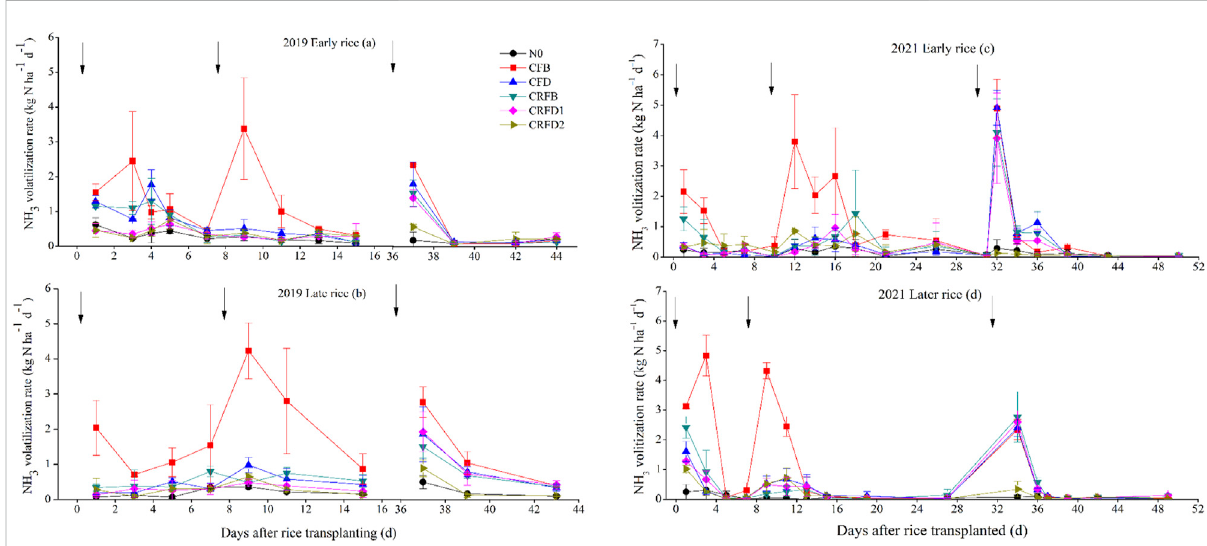
FIGURE 2 The NH 3 volatilization fl uxes for early (A,C) and late rice (B,D) under different treatments in 2019 (A,B) and 2021 (C,D) . Values are presented as the mean ± standard deviation ( n = 3). The arrow represents the timing of N fertilizer application, following basal, tillering and panicle fertilizations, respectively.N0:noNfertilizer;CFB:compoundfertilizerbroadcasting;CFD:compoundfertilizerside-deepplacement;CRFB:controlled-releaseN fertilizer broadcasting; CRFD1: controlled-release N fertilizer side-deep placement; CRFD2: controlled-release N fertilizer side-deep placement, one-time fertilization.